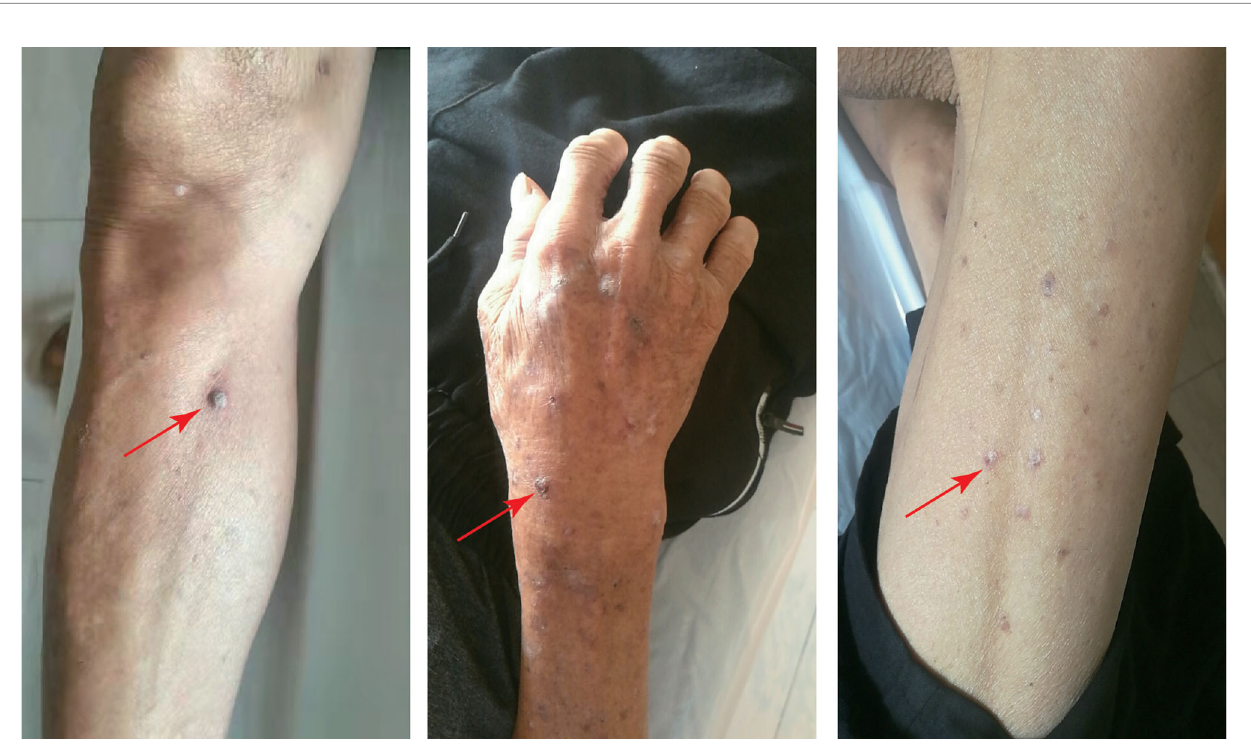
FIGURE 4 | The patient experienced mild cutaneous responses. Scattered gray papules formed on the skin of the patient ’ s